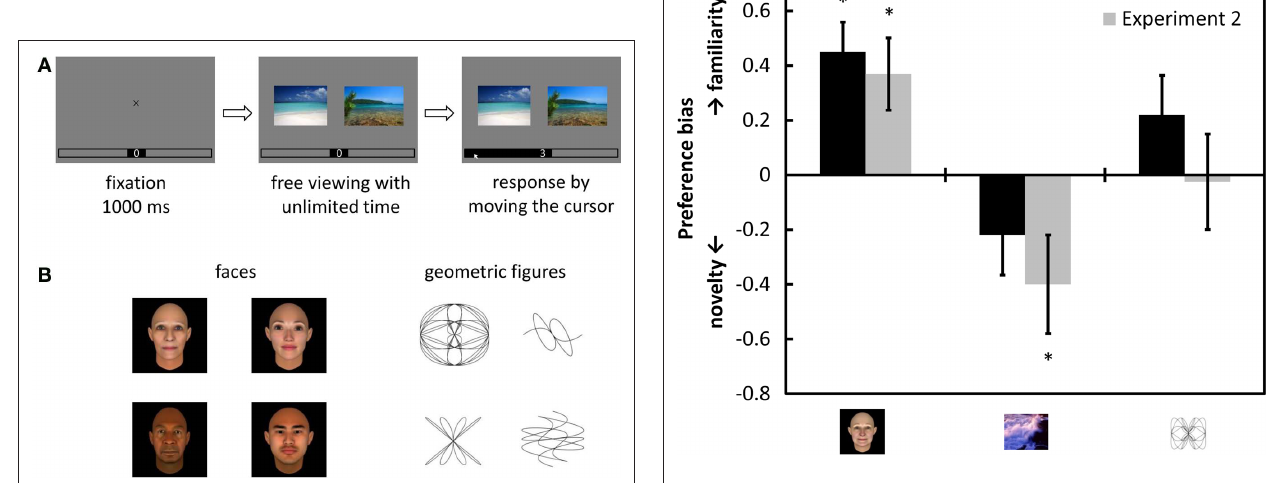
Figure 2 | Mean preference bias among initial preference judgments in experiments 1 and 2. Error bars represent one standard error of the mean. Asterisks indicate statistically significant differences from